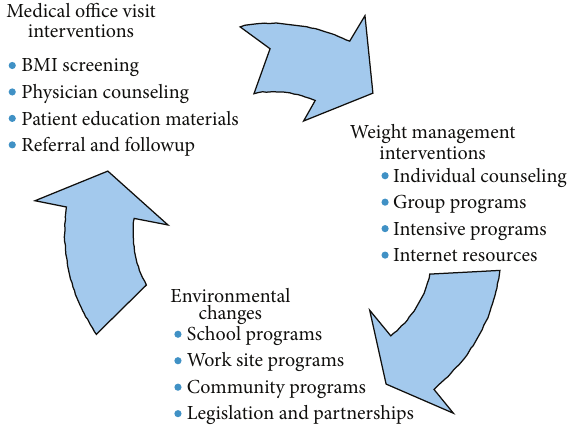
Figure 1: KPNC’s approach to childhood